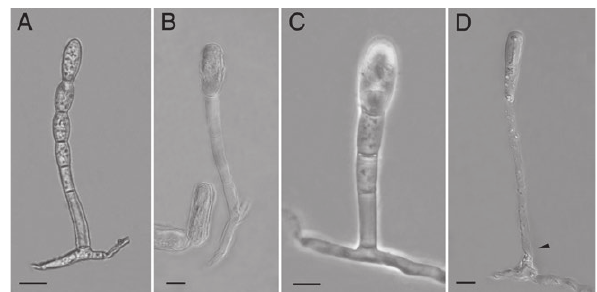
Figure 2. Conidiophore morphology of the four different pow- dery mildew morphological types designated in this study. A) Podosphaera xanthii, B) Erysiphe sp., C) E. cruciferarum , D) E. neca- tor . Arrow in D) indicates the twisted conidiophore foot cell, char- acteristic of E. necator. Bars = 20